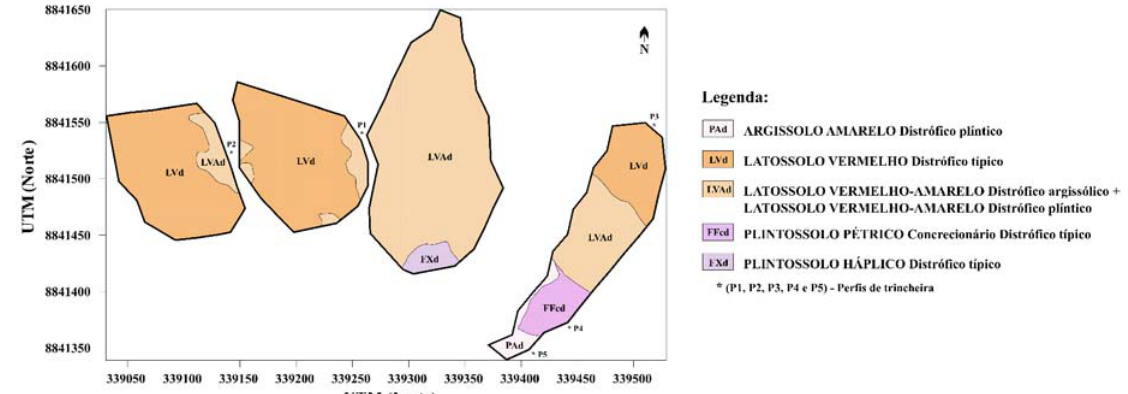
Figura 7. Distribuição das classes de solos das microbacias, segundo o SiBCS (Embrapa, 1999), em escala aproximada de 1:4.500.